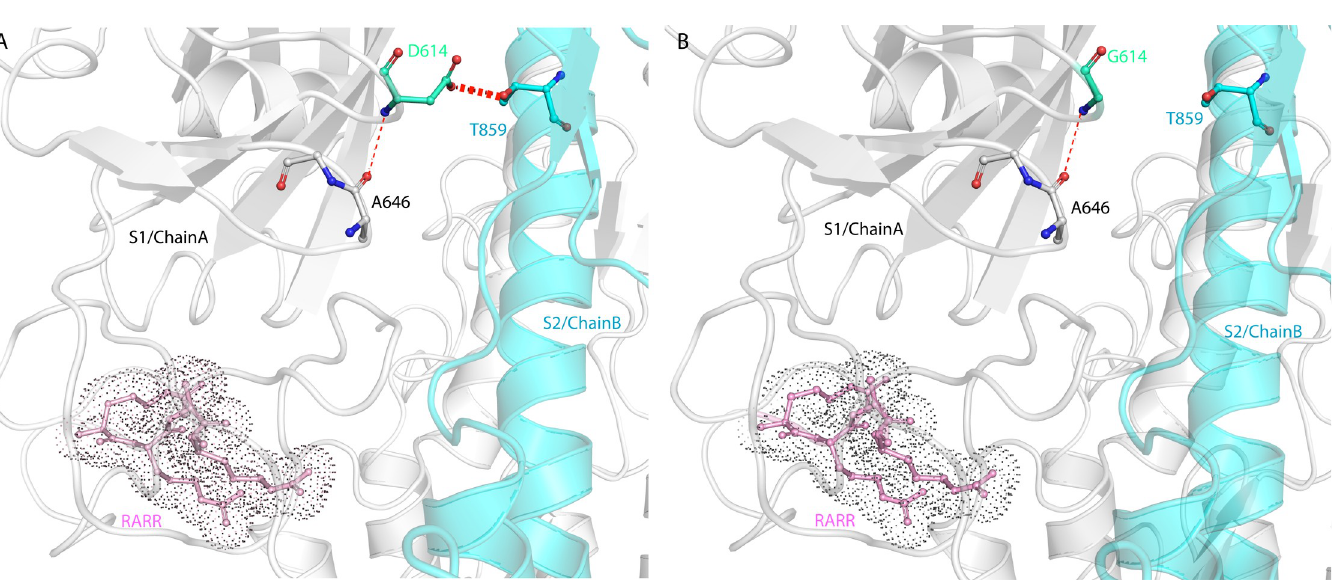
Fig 7. 3D modelling of SARS-CoV-2 Spike protein showing suggested bonds for D614. (A) Suggested hydrogen bonds (red dashed lines) of D614 (S1 domain chain A) with T859 (S2 domain chain B) and D614 and A646 of S1 domain chain A. (B) The suggested hydrogen bond can be disrupted with the D614G mutation altering the activity of the